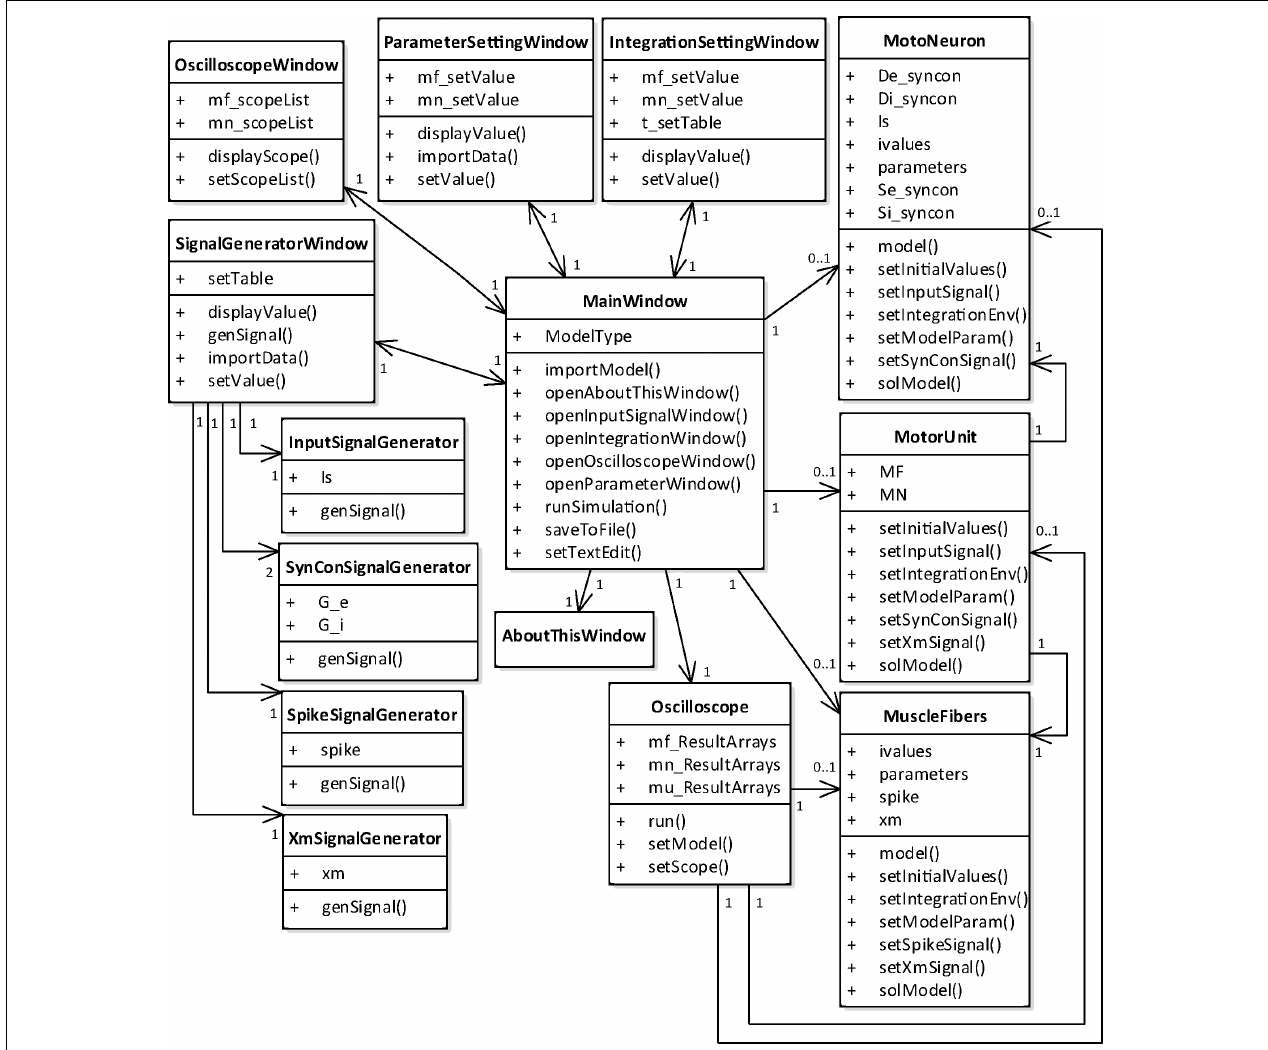
FIGURE 4 | Class diagram for PyMUS. The MainWindow class is mutually associated with all classes for the graphical user interfaces (AboutThisWindow, ParameterSettingWindow, IntegrationSettingWindow, SignalGeneratorWindow and OscilloscopeWindow) and includes the classes for the model construction and simulation (Oscilloscope, MotoNeuron, MuscleFibers, and MotorUnit). The SignalGeneratorWindow class further includes four classes for generation of input signals (InputSignalGenerator, SynConSignalGenerator, SpikeSignalGenerator, and XmSignalGenerator). The MotoNeuron class, MuscleFibers class and MotorUnit class are selectively included in the MainWindow class depending on the model type selected by the users in the main window.